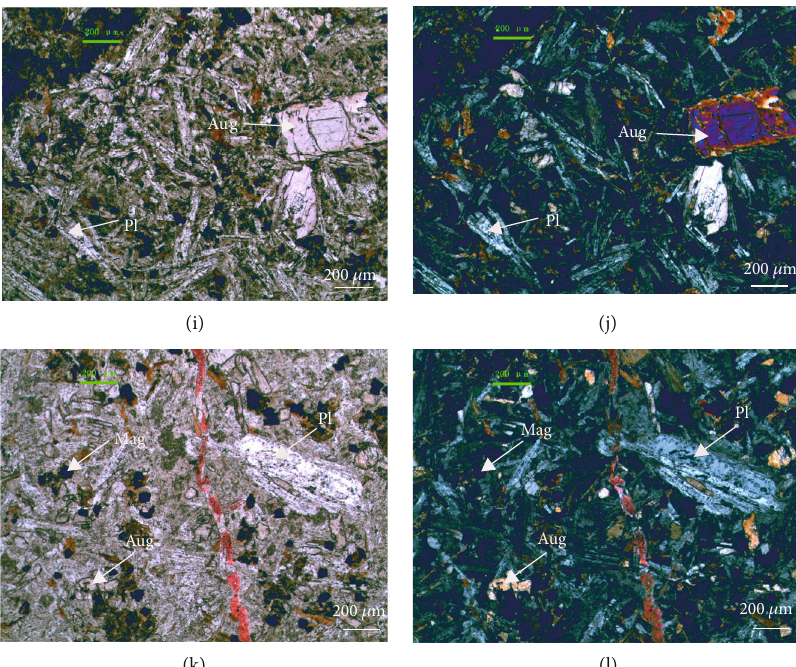
Figure 3: Microphotographs for Paleogene ma fi c rocks in Huimin Sag. (a, b) Intrusive rock from Xia 38 well, 3830.4m. This sample is mainly composed of plagioclase and augite, with minor amphibole and magnetite and has a poikilitic texture. Corrosion of amphibole and sericitization of plagioclase can be seen. (c, d) Intrusive rock from Xia 38 well, 3668.5m. This sample is mainly composed of plagioclase and augite and has a poikilitic texture. The augite shows latticed corrosion and obvious chloritization. The plagioclase experienced severe dissolution, and the dissolved pores were fi lled with asphaltic components. (e, f) Intrusive rock from Xia 381 well, 4006.1m. This sample is mainly composed of plagioclase, augite, and olivine with minor amphibole and magnetite and has an ophitic texture. The augite and plagioclase were severely dissolved, and the pores were fi lled with asphaltic components. (g, h) Volcanic rock from Shang 745 well, 3215.2m. This sample has a porphyritic texture with the matrix showing intergranular and interseptal textures. The phenocrysts are mainly plagioclase and augite, whereas the matrix is composed of subdirectionally distributed fi ne lath plagioclase, pyroxene, and glass, with a small amount of hornblende. (i, j) Volcanic rock from Shang 745 well, 3200.2m. This sample has an interseptal texture and is mainly composed of randomly distributed long strip plagioclase, the spaces of which fi lled with granular pyroxene and glass that experienced devitri fi cation, as well as a small amount of large pyroxene particles, with some of which have been saponi fi ed. (k, l) Volcanic rock from Shang 745 well, 3200.2m. This sample has an interseptal texture, with a locally intersertal texture. It is mainly composed of randomly distributed long strip plagioclase, the spaces of which fi lled with granular pyroxene and magnetite. Structural fractures that fi lled with calcite can be seen. Pl — plagioclase; Hbl — hornblende; Ol — olivine; Aug — augite; Mag —